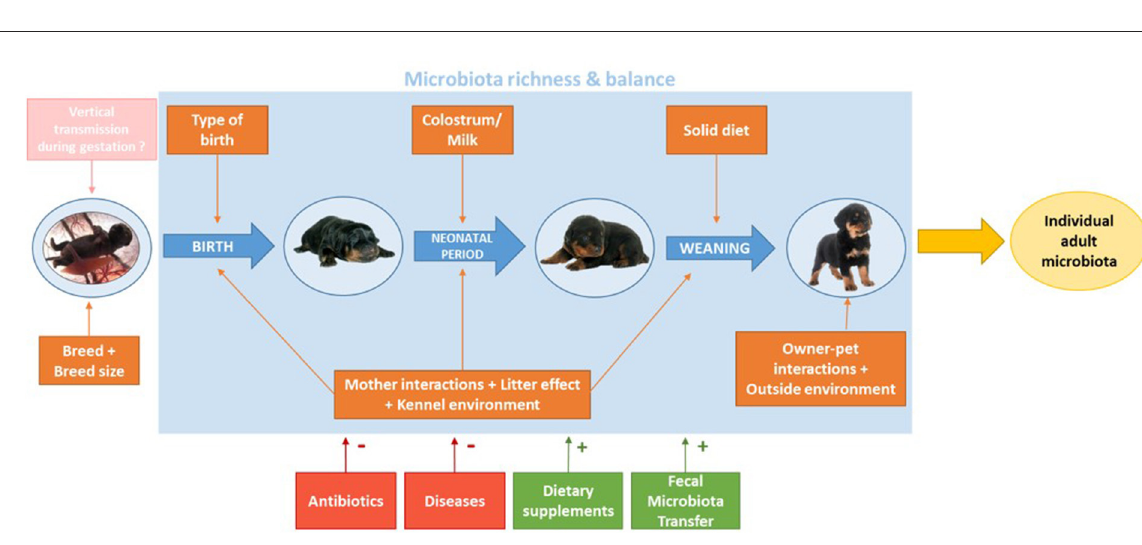
FIGURE3 Major factors shaping the development of growing puppies’ gut microbiota from birth to adulthood. Orange boxes show obligate factors, while the pink box illustrates a hypothetical impact. Factors in red boxes are facultative factors that can be associated with dysbiosis, while green boxes are facultative factors with beneficial effects on microbiota